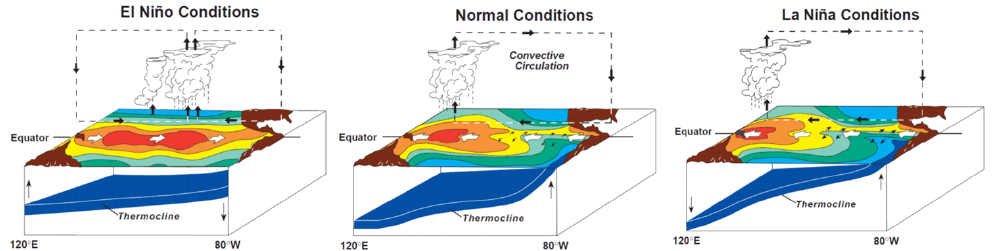
Figure 3. Model of surface temperature, wind, area of rising air and thermoline (blue surface) in the tropical Pacific during El Niño, Normal, and La Niña (https://reefresilience.org/th/stressors/climate-and-ocean-change/el-nino-southern-oscillation/, accessed on 24 March 2022).